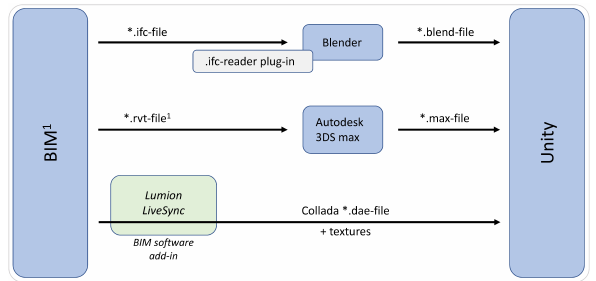
Figure 2: Diagram of the different methods to import a BIM model into the Unity gaming engine environment. ( 1 We used Au- todesk Revit as BIM